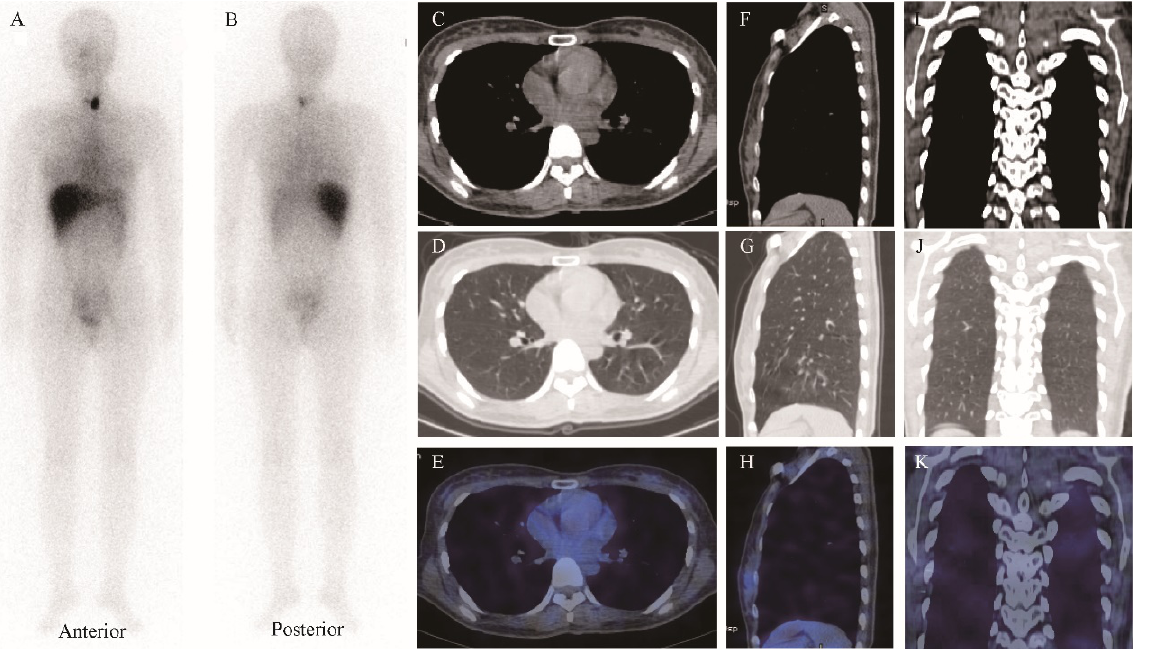
Figure 4. Whole-body scan (( A ), anterior view; ( B ), posterior view) on day 9 post 131 I administration, showing 131 I accumulation only in the thyroid lobe remnant. SPECT/CT images of chest ( C – E ), transaxial; ( F – H ), sagittal; and ( I – K ), coronal), showing neither 131 I accumulation in the chest nor pleural effusion. Table 1. Laboratory data before and after 131 I administration.